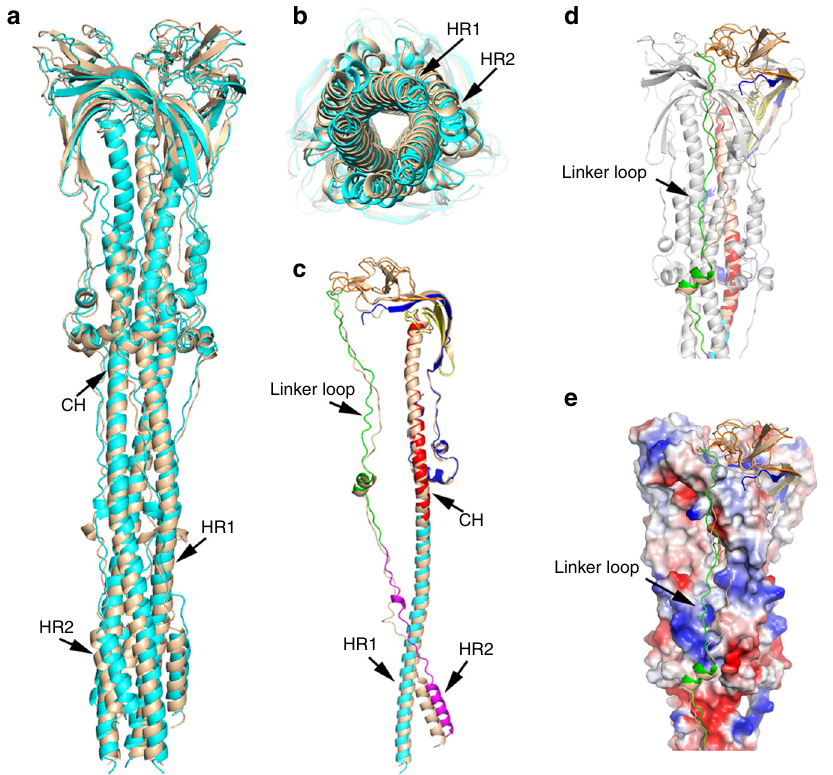
Fig. 4 Comparison of SARS-CoV and MHV S2 structures in post-fusion state. a , b Cartoon representation of the comparison of post-fusion S2 overall structures from SARS-CoV (cyan) and MHV 39 (PDB: 6B3O, wheat). c Superposition of SARS-CoV (colored as Fig. 1a) and MHV 39 (PDB: 6B3O, wheat) post-fusion S2 subunits in single chain mode. d , e Structural comparison of the linker region upstream of HR2 motif from SARS-CoV (green) and MHV 39 (PDB: 6B3O, wheat) shown as cartoon and electrostatic surface. Red represents negative charge, and blue represents positive